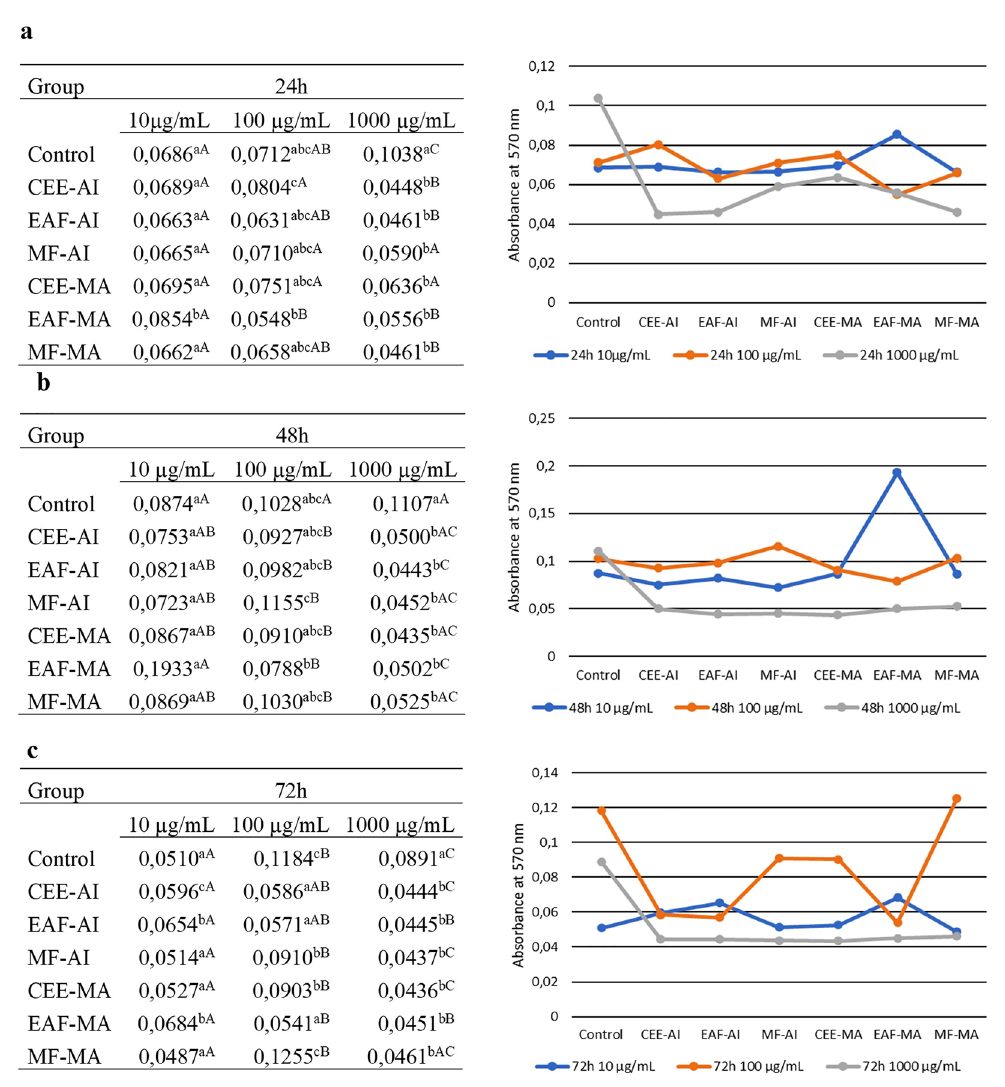
Figure 2. Tabulated and graphed values of absorbance (570 nm) obtained by the 3–4,5-dimethyl-thiazol-2-yl- 2,5-diphenyltetrazolium bromide (MTT) test after the action of crude extracts of Azadirachta indica and Melia azedarach and their respective fractions of ethyl acetate and methanol for 24 h, 48 h, and 72 h. ( a ) treatment with the extracts and their respective fractions at concentrations of 10, 100, and 1000 µg/mL within 24 h; ( b ) treatment with the extracts and their respective fractions at concentrations of 10, 100, and 1000 µg/mL within 48 h; ( c ) treatment with the extracts and their respective fractions at concentrations of 10, 100, and 1000 µg/mL within 72 h CEE-AI: crude ethanolic extract— Azadirachta indica ; EAF-AI: ethyl acetate fraction— Azadirachta indica ; MF-AI: fraction methanol— Azadirachta indica ; CEE-MA: crude ethanolic extract— Melia azedarach ; EAF-MA: ethyl acetate fraction— Melia azedarach ; MF-MA: fraction methanol— Melia